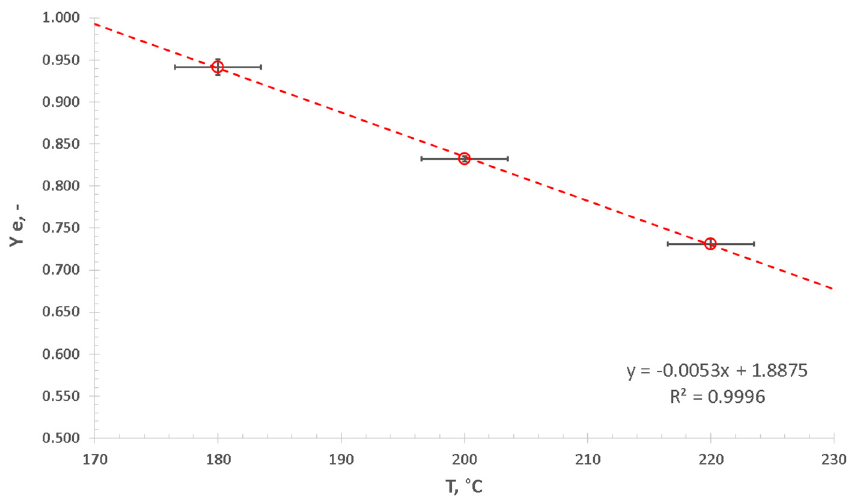
Figure 4. Energy yield for the performed HTC experiments.